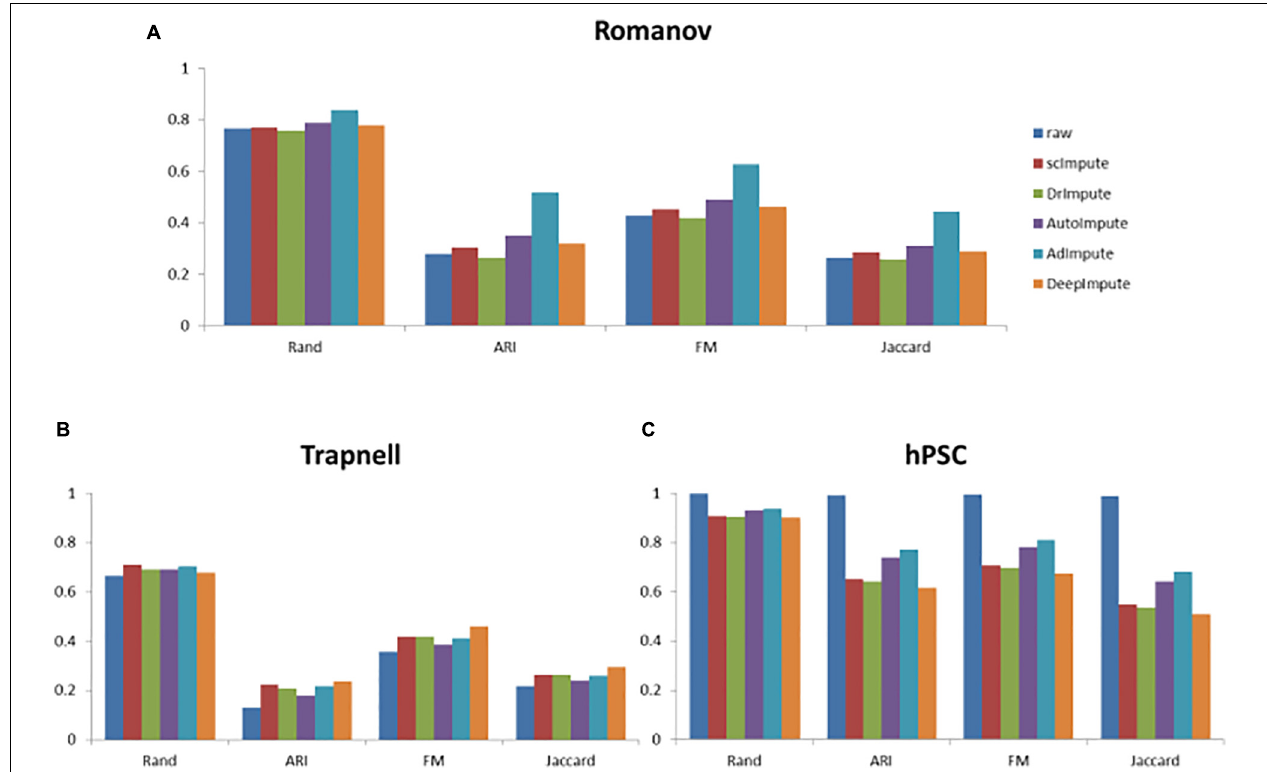
FIGURE 8 | The histogram of clustering evaluation indexes on the real data sets, including the clustering evaluation indexes of raw data and the clustering evaluation indexes after imputing by scImpute, DrImpute, AutoImpute, AdImpute, and DeepImpute. And (A) is the clustering evaluation indexes on Trapnell (GSE52529) data set; (B) is the clustering evaluation indexes on hPSC (GSE75748) data set; (C) is the clustering evaluation indexes on Romanov (GSE74672) data set.